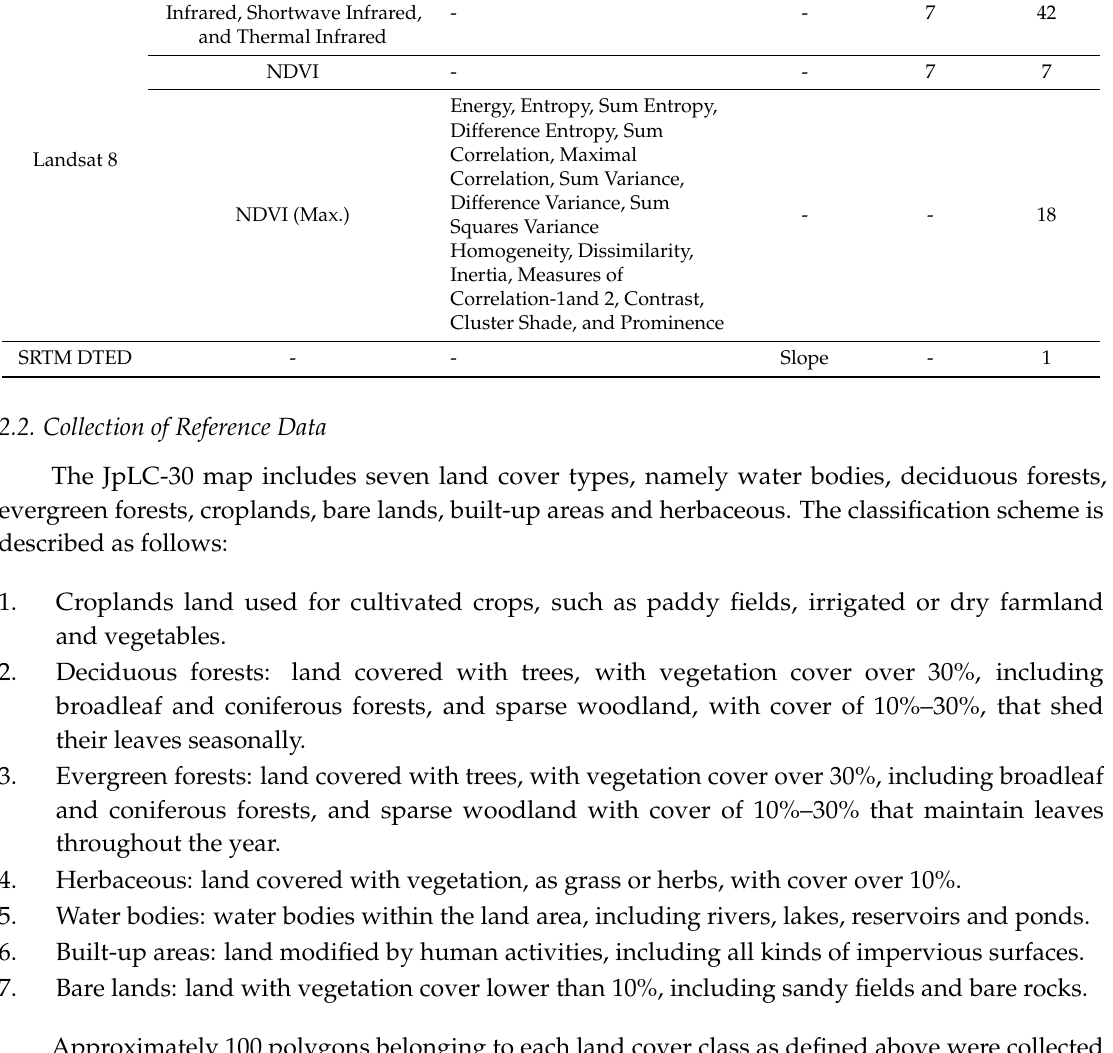
Table 1. List of spectral, textural and topographic feature images used in the research. DTED, Digital Terrain Elevation Data. Spectral Textural Topographic Temporal Blue, Green, Red, Near Infrared, Shortwave Infrared, - - 7 42 and Thermal Infrared NDVI - - 7 7 Energy, Entropy, Sum Entropy, Difference Entropy, Sum Correlation, Maximal Landsat 8 Correlation, Sum Variance, Difference Variance, Sum NDVI (Max.) Squares Variance Homogeneity, Dissimilarity, Inertia, Measures of Correlation-1and 2, Contrast, Cluster Shade, and Prominence SRTM DTED - - Slope -